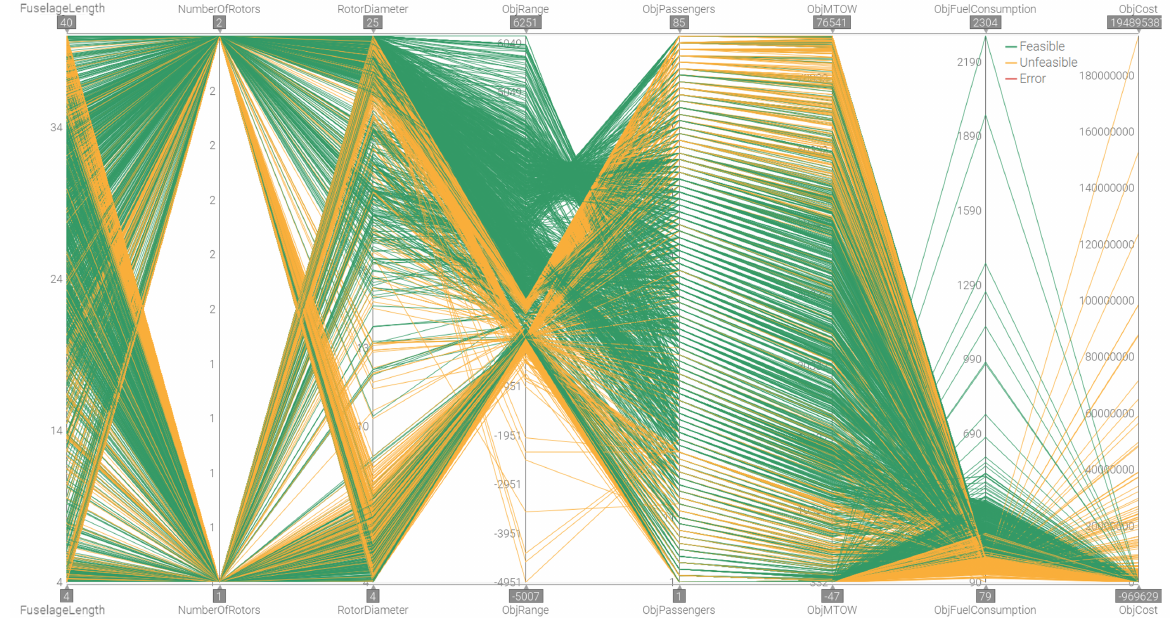
Figure 9. A parallel coordinates graph showing the relationships between design parameters and optimization objectives for each design alternative.